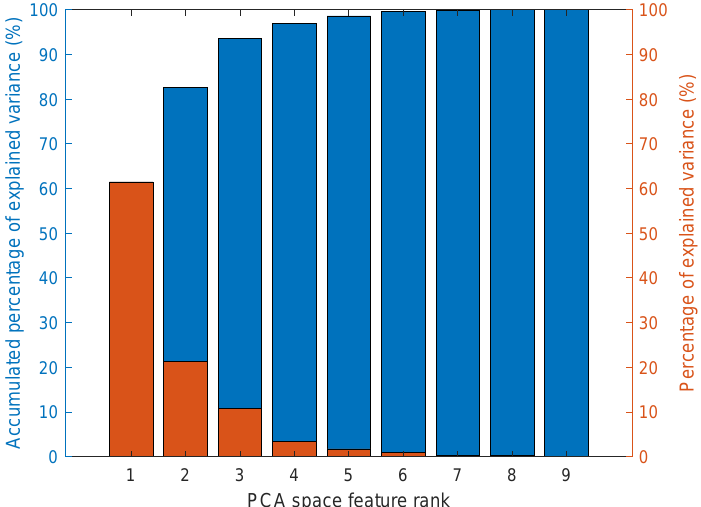
Figure 8. Accumulated PCA feature ranking.